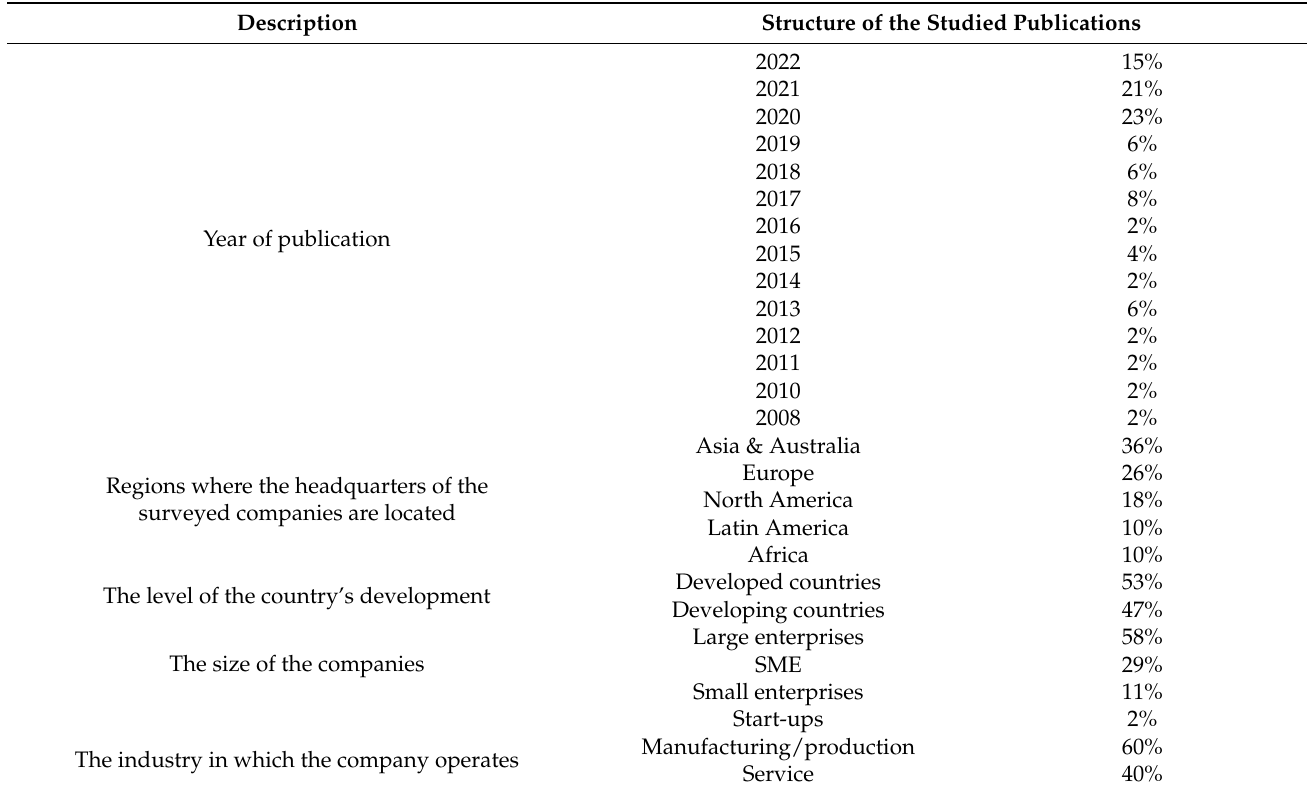
Table 3. The characteristics of the research sample.